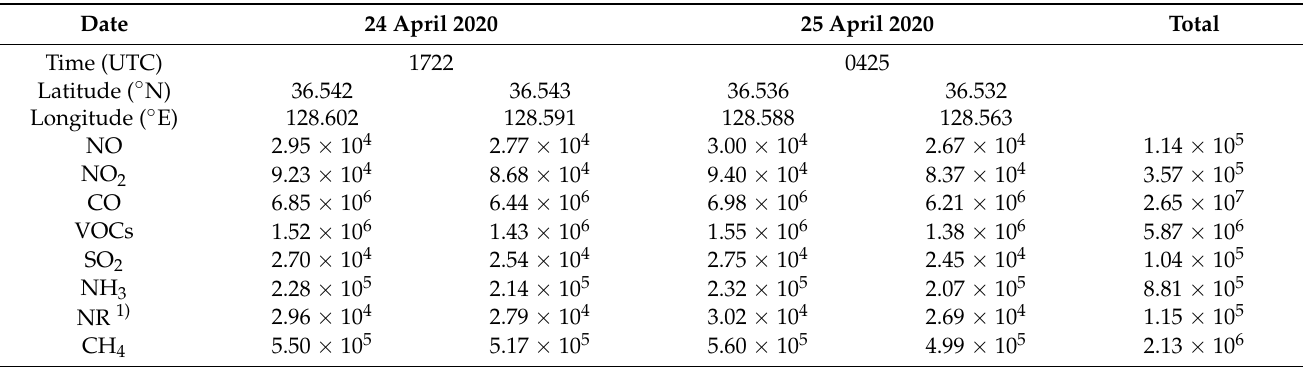
Table 1. Total emissions of gaseous pollutants from Andong wildfire in FINN emission data (unit of pollutants: